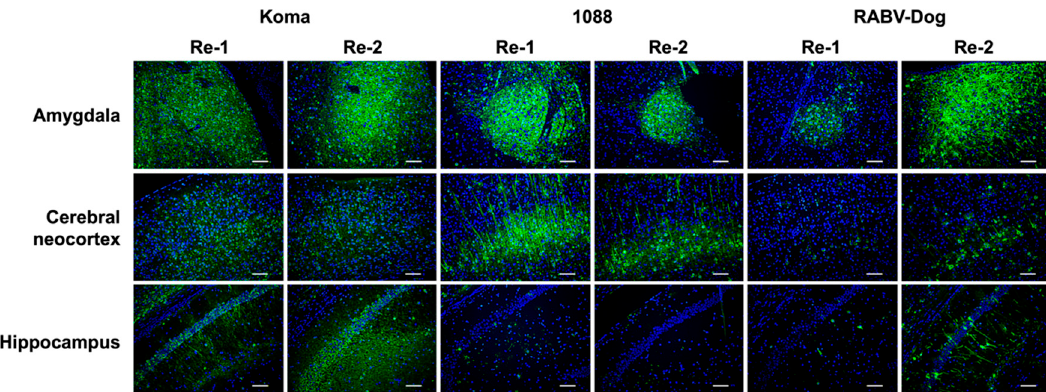
Figure A1. Distribution of viral antigens in the amygdala, cerebral neocortex, and hippocampus in mice infected with the virus strains. The distribution of viral antigens in the brain was re ‐ examined by using each of two brain samples infected with the Koma, 1088, or RABV ‐ Dog strain. Viral protein and nuclei were stained with an anti ‐ RABV P protein antibody (green) and DAPI (blue), respectively. The scale bars correspond to 100 μ m. These samples were photographed by using the Biozero fluorescence microscope BZ ‐ 8000 series (Keyence).